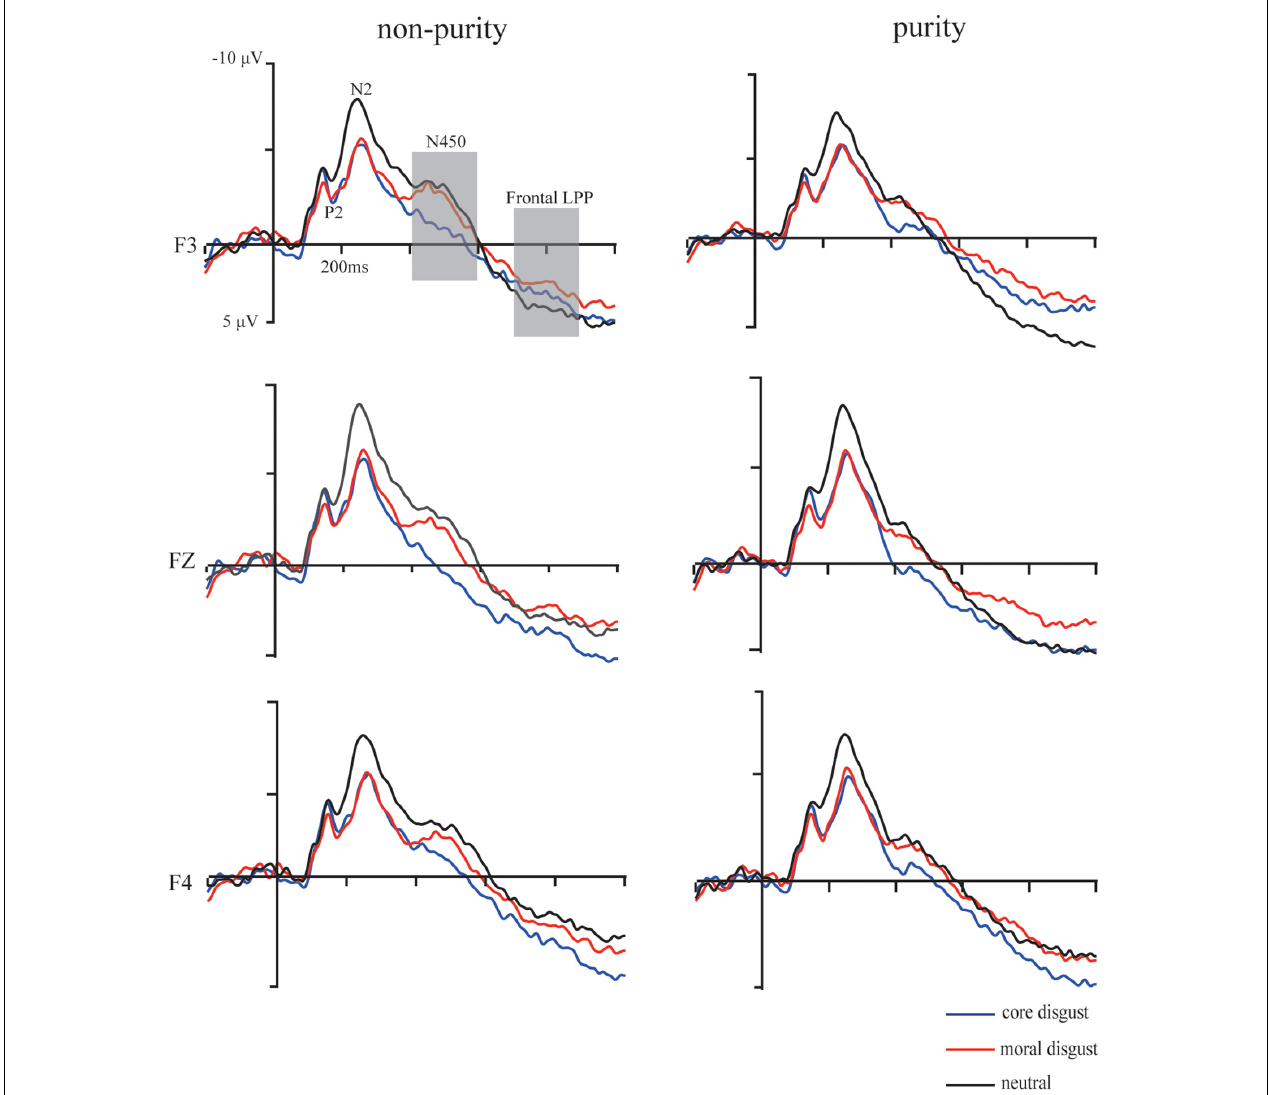
FIGURE 3 | Grand-average event-related potential waveforms for moral disgust (a red solid line), core disgust (a blue solid line), and neutral (a black solid line) groups under purity conditions at F3, Fz, and F4 electrodes. The gray bars highlight the time window of the N450 (400–600 ms) and frontal LPP (700–900